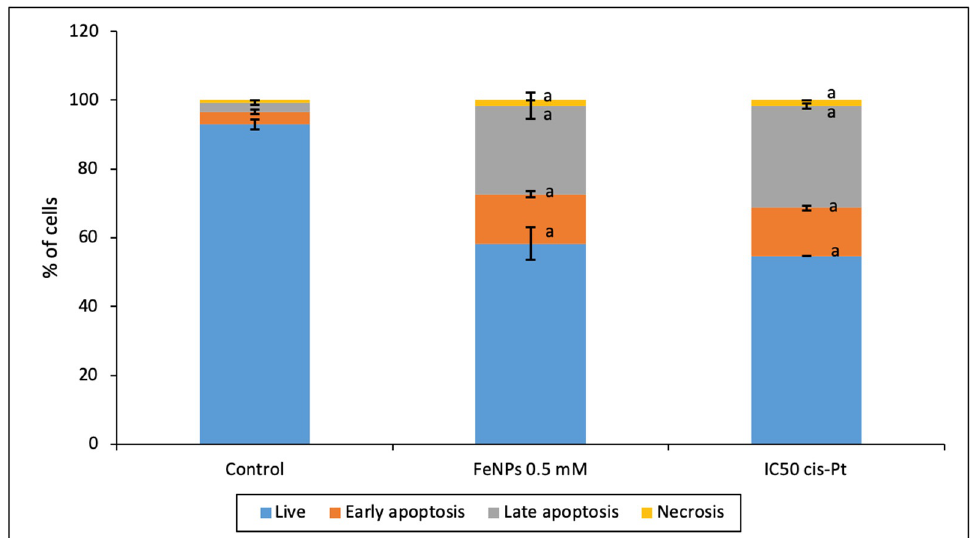
Figure 10. Evaluation of apoptosis/necrosis by flow cytometry. Results expressed as mean ± SEM. (a) vs. control ( p < 0.05).